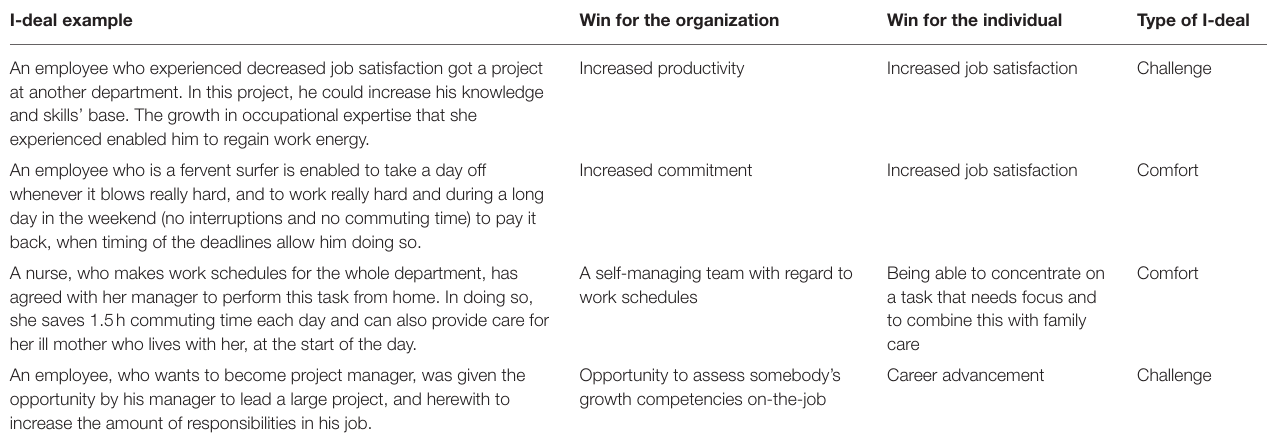
TABLE 1 | Examples of I-deal types and their win-win outcomes. I-deal